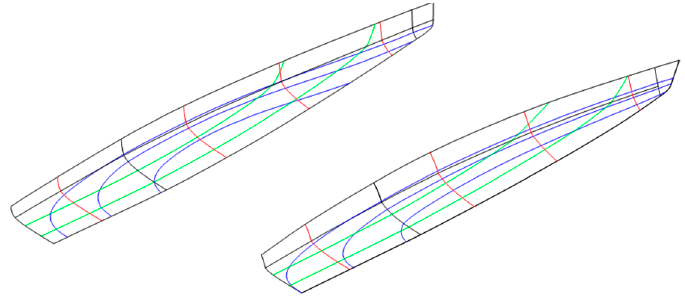
Figure 17. Rebuilt hull surfaces: LED ( left ) and TryAgain ( right ).